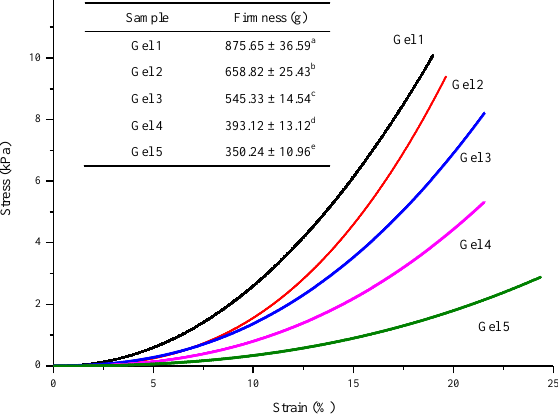
Figure 8. Stress/strain curves of hydrogels. Sample with different lower case superscript are significantly different at p <